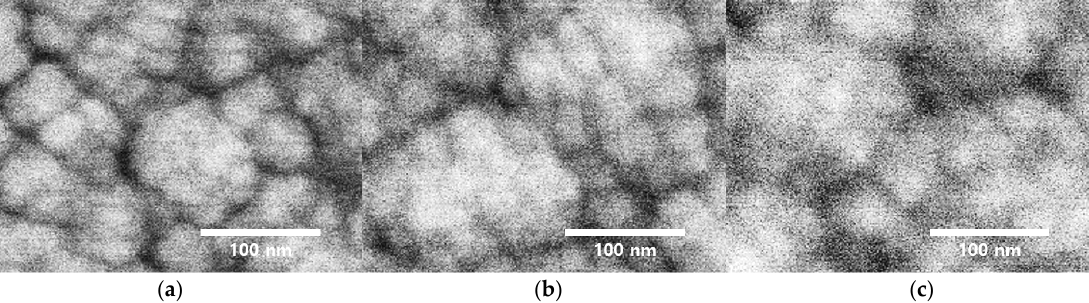
Figure 2. AlN film morphology SEM imaging ( a ) as-grown, ( b ) N 2 -annealed, and ( c ) O 2 -annealed samples.